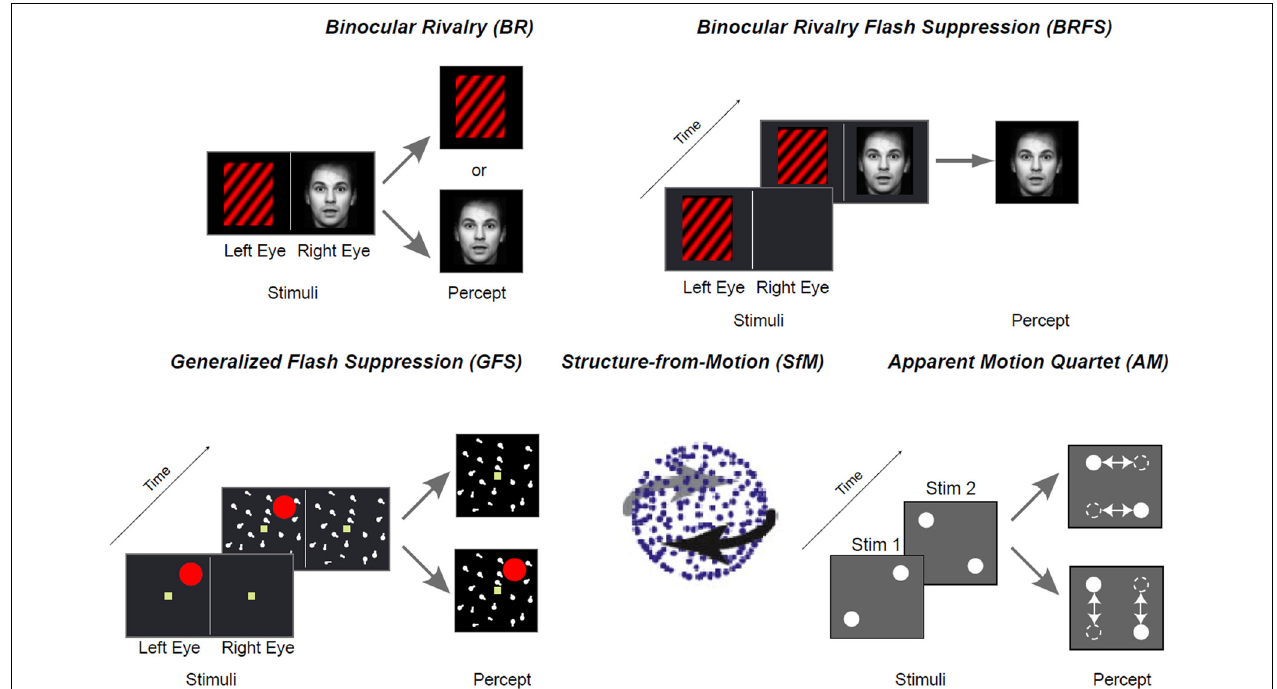
FIGURE 5 | Examples for bistable stimuli used to investigate the neurophysiological correlates of conscious perception in monkeys.